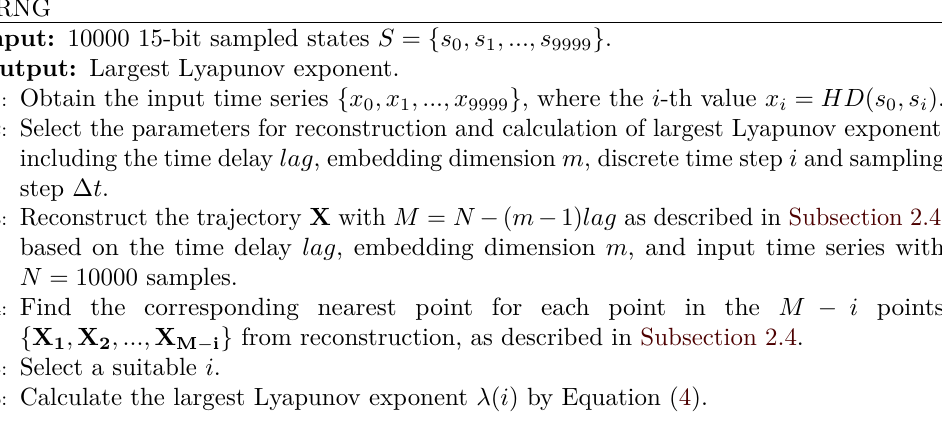
Algorithm 1 The calculation of the largest Lyapunov exponent for FIRO-/GARO-based